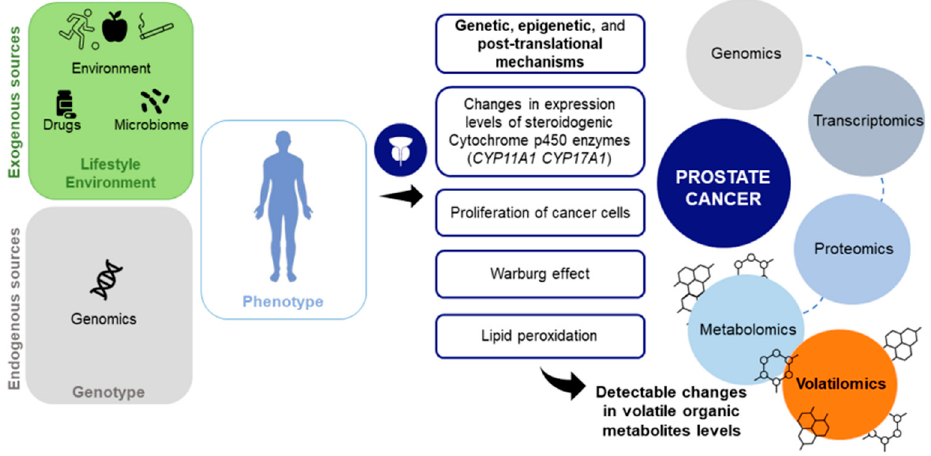
Figure 4. Cancer-related metabolic and biochemical activities can be detected through volatile or- ganic metabolites. The establishment of a volatilomic biosignature can lead to the discovery of bi- omarkers for prostate cancer